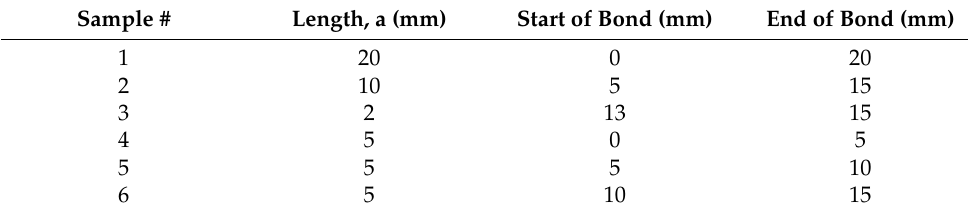
Table 2. FBG bonding